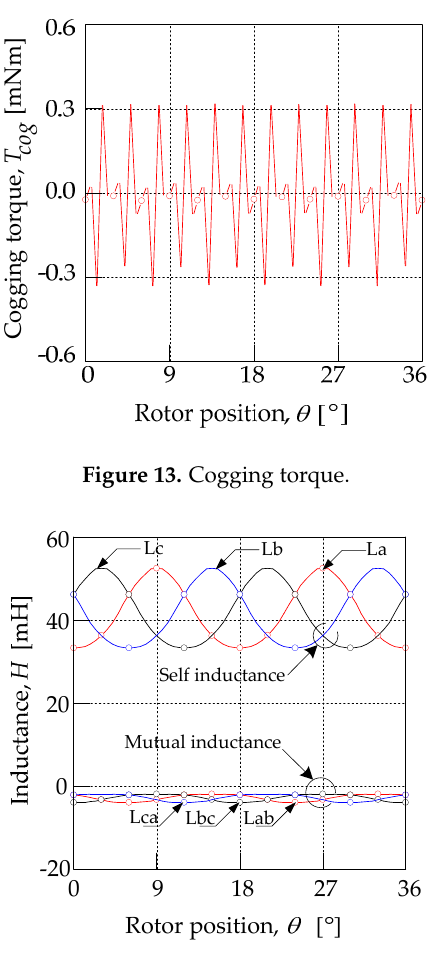
condition as shown in Figure 13. The cogging torque produced by the interaction of poles and stator